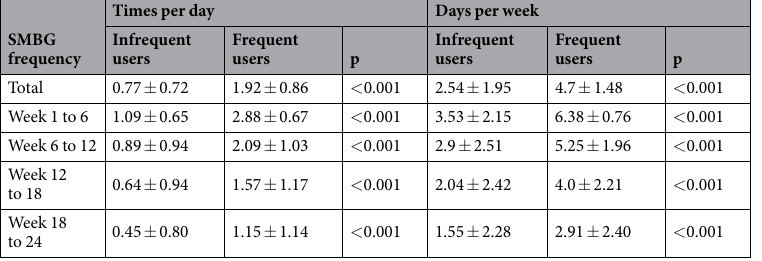
Table 3. SMBG frequency between frequent users and infrequent users. Data are expressed as the mean ± SD.